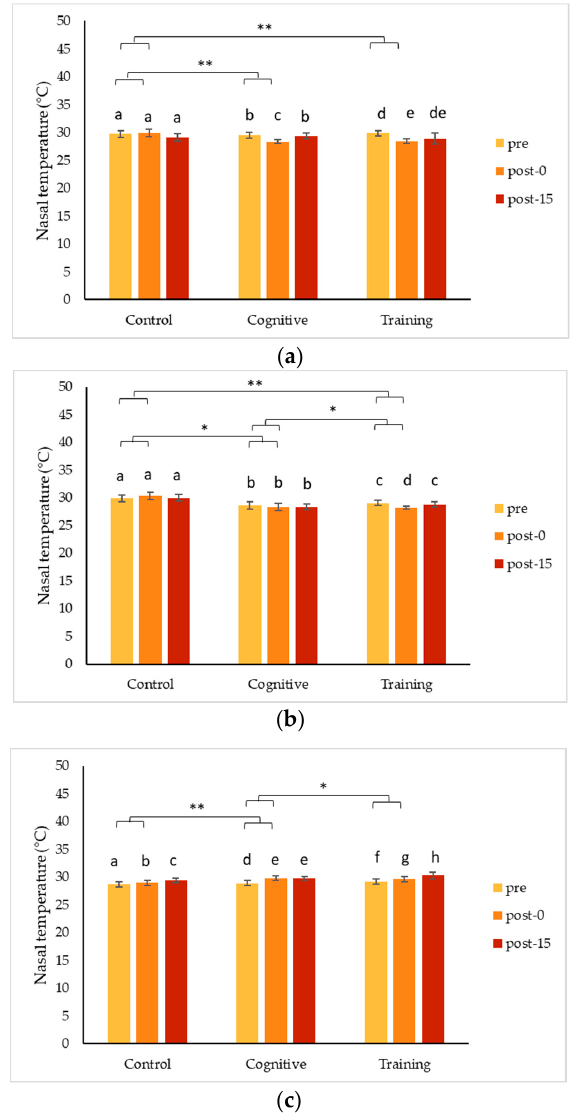
Figure 3. Minimum nasal temperatures (mean ± standard error) across three time points for two types of human–animal interactions and a control condition for ( a ) Chip; ( b ) Pende; and ( c ) Kongo. Brackets with ** indicate a significant difference of p < 0.05 and * indicate a trend (0.05 ≤ p < 0.1) for changes in temperature (calculated by subtracting pre from post-0 measurements) between conditions. Bars with different letters within a condition are significantly different or trending at p < 0.10 comparing time points within that condition. All tests were conducted using Wilcoxon signed rank tests with Monte Carlo sampling.